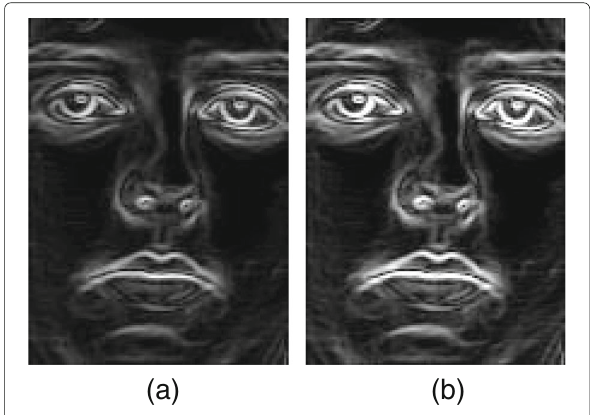
Fig. 3 a Sobel gradient magnitude image. b Scharr gradient magnitude image